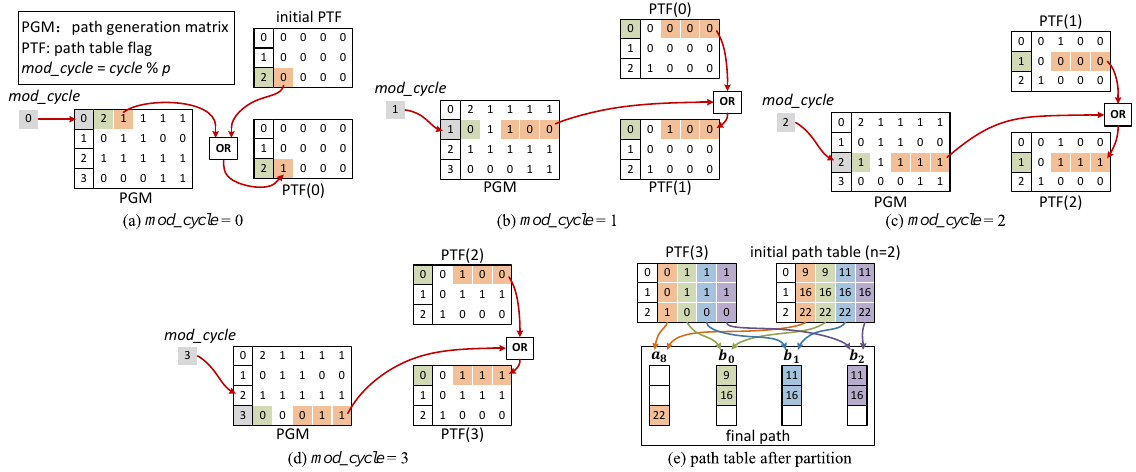
Figure 9. The example of path partition of iteration 2 in Figure 6. ( a – d ) the process of obtaining PTF(3); ( e ) PTF(3) combined with the initial path table to get the final